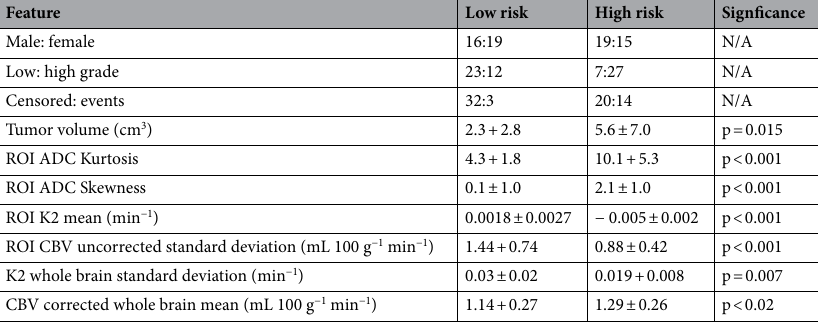
Table 3. Low and high-risk cluster group features.